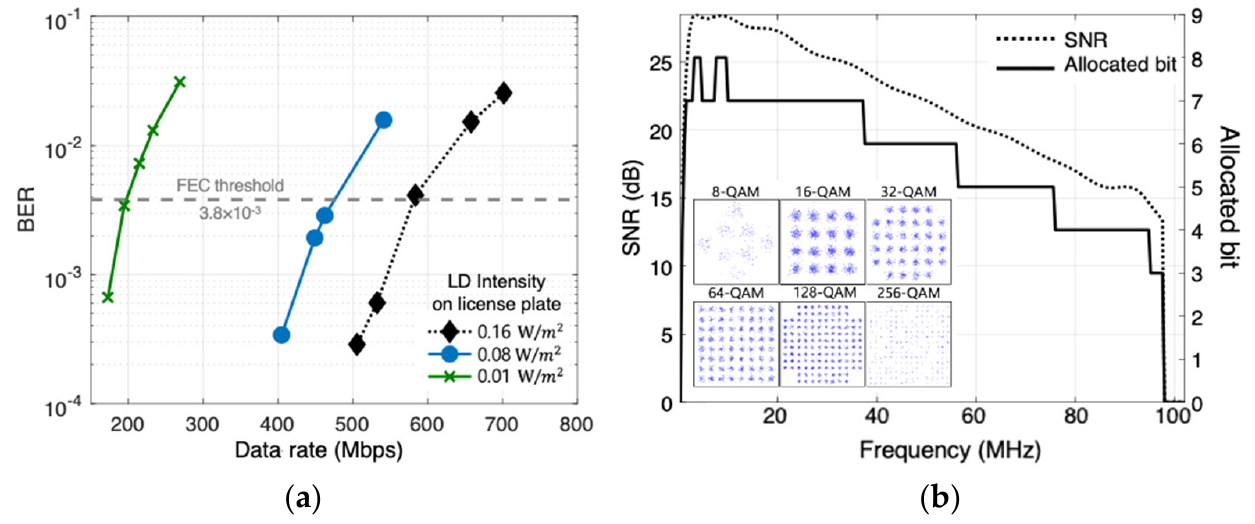
Figure 8. ( a ) BER performance according to output power of LD; and ( b ) constellations, measured SNR and allocated bits with adaptive bit and power loading.